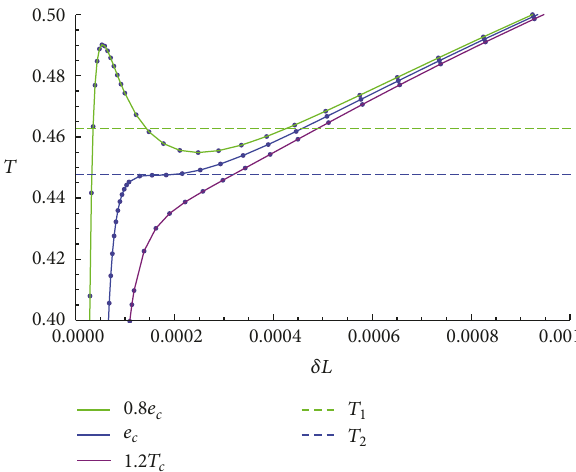
Figure 6: Relations between geodesic length and temperature for different 𝑒 with 𝑞 = 0.05 , 𝜃 0 = 0.2 .